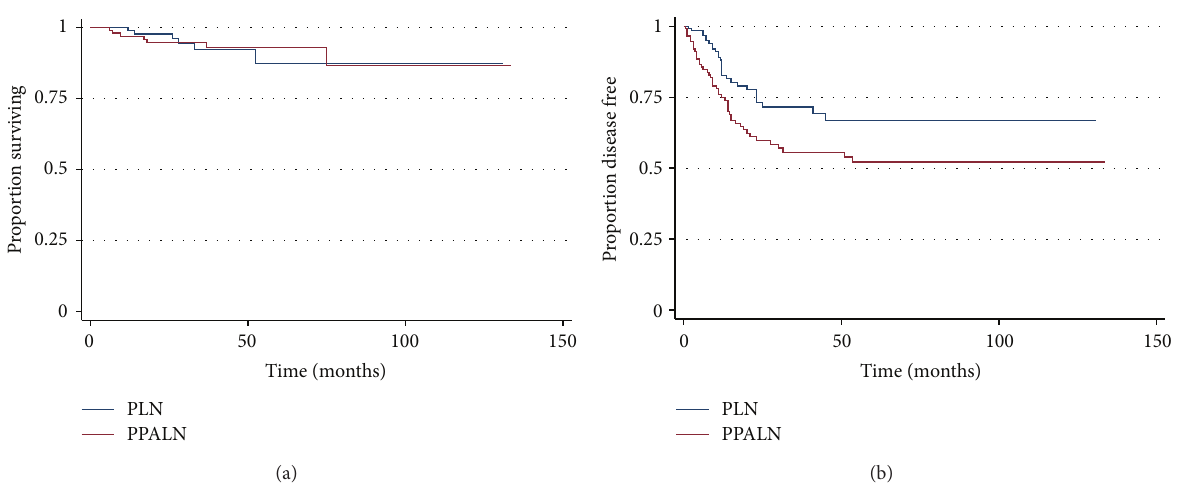
∗ PPALN patients with less than 10 para-aortic nodes dissected. ∗∗ PPALN patients with 10 or more dissected para-aortic nodes.